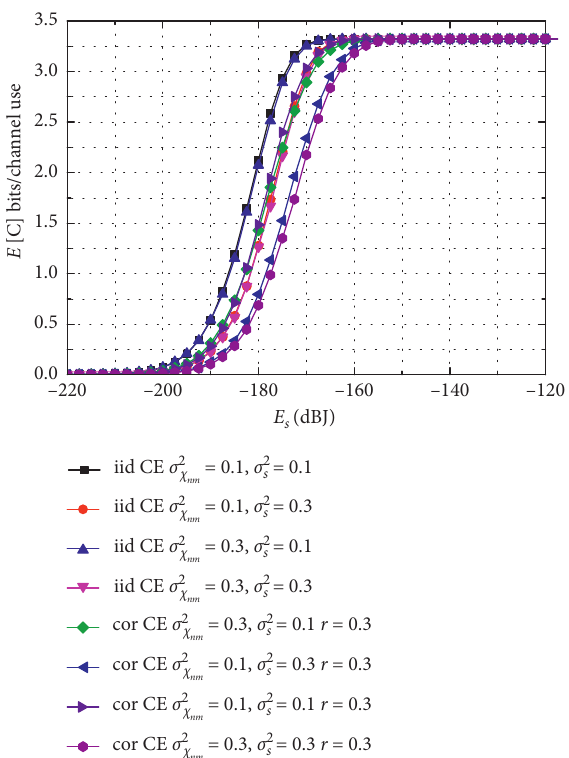
Figure 11: Ergodic channel capacity with combined effects over correlated channel for different atmospheric turbulence and pointing error jitter